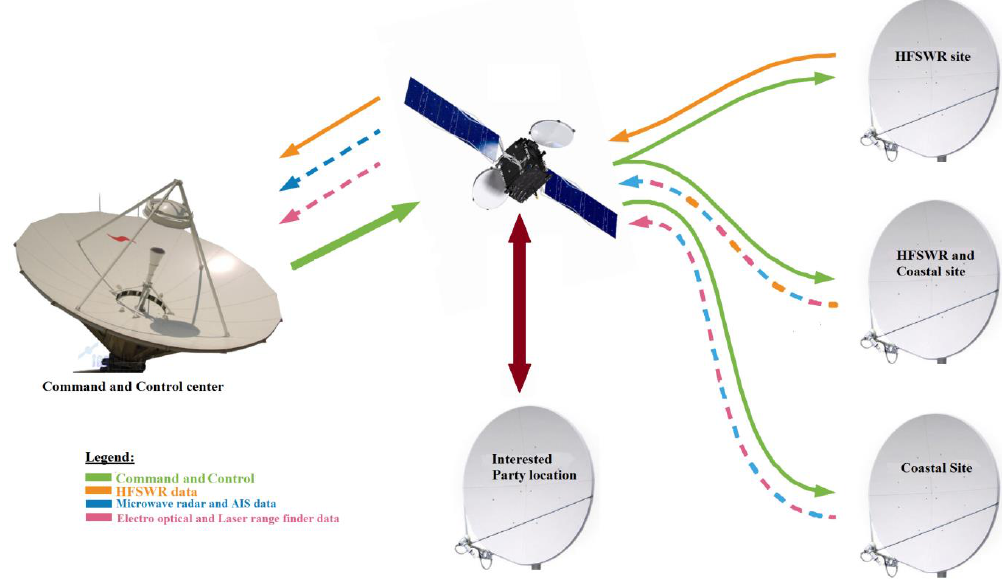
Figure 2. Communication infrastructure between the command and control center and remote locations.